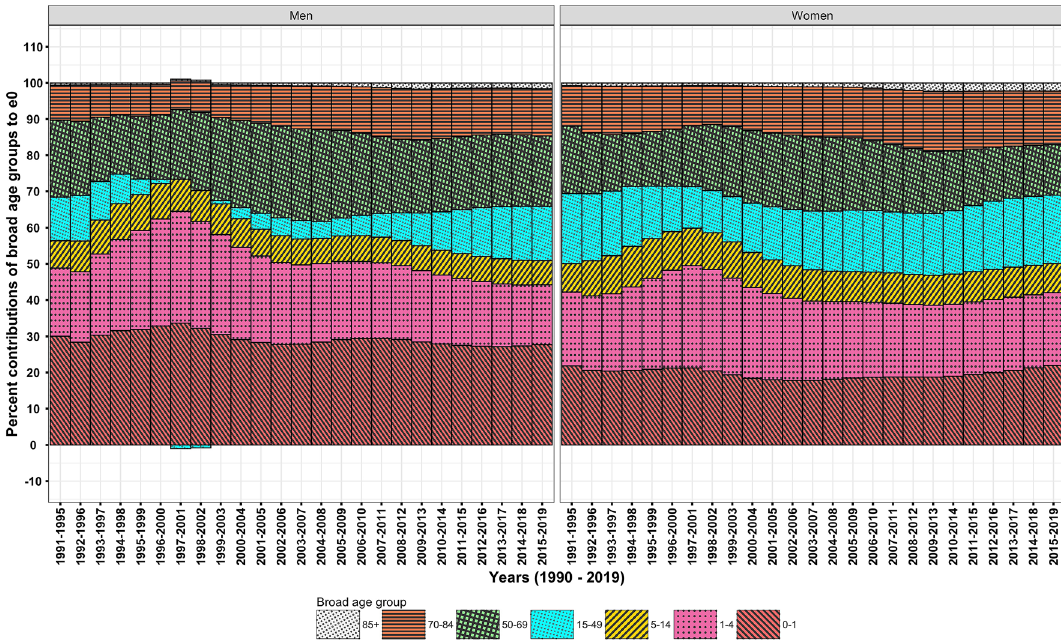
Figure 2. Temporal changes in age-specific contributions to Δe 0 , men and women, 1990–2019.